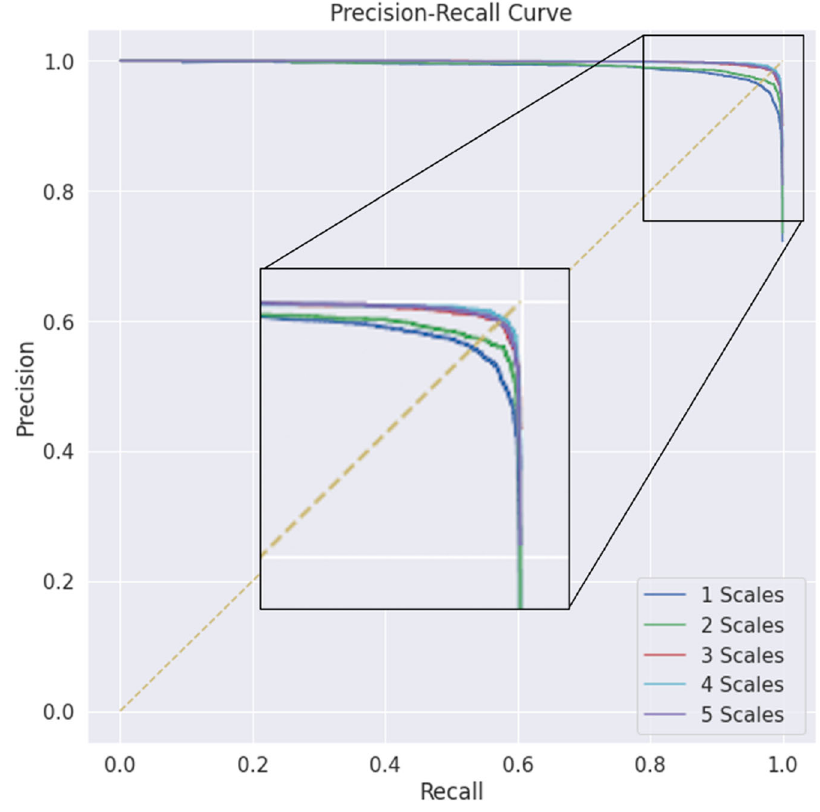
Figure 11. The precision–recall curves at different scales and kernel sizes.